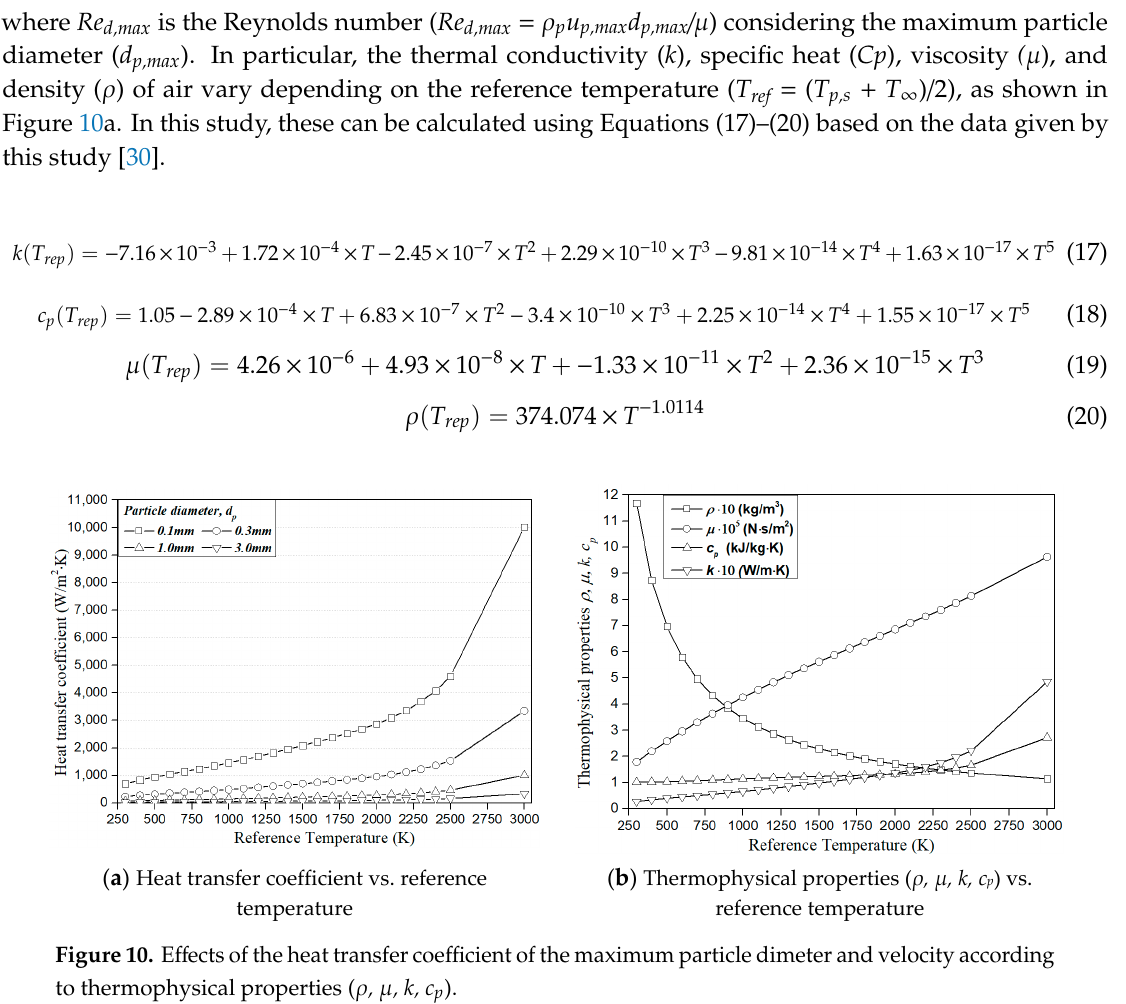
Figure 9. Results of the particle velocity according to the particle diameter.